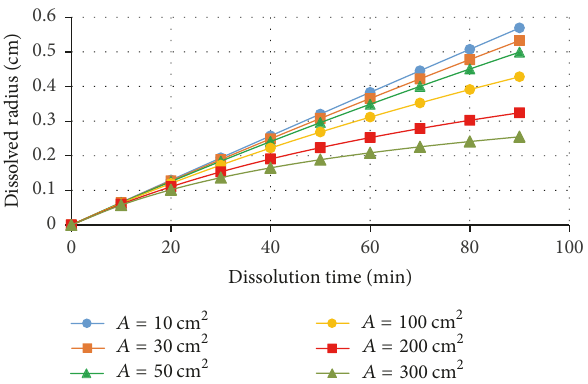
Figure 10: Change of the dissolved radius with dissolution time for different initial volumes ( V ).